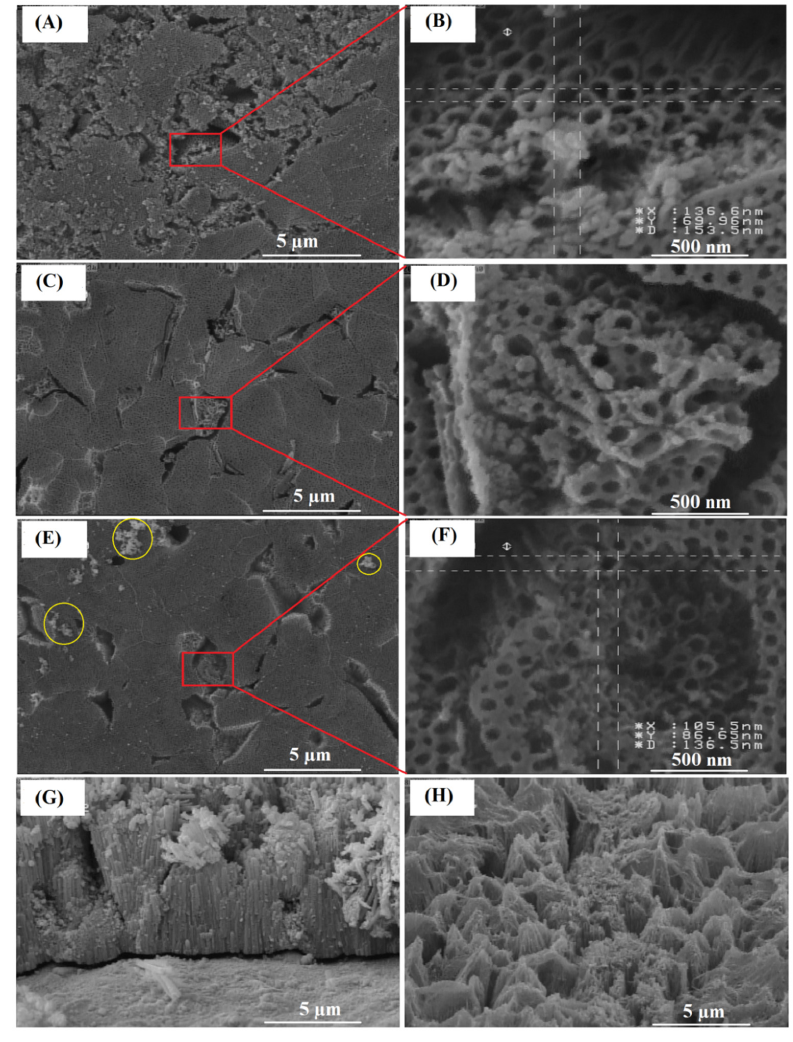
Figure 2. SEM images of decorated CT with Pd photo-deposition: Pd-CT-1 ( A , B ), Pd-CT-2 ( C , D ), Pd-CT-3 ( E , F ) at different magnitude, the red lines show the selected part of SEM images at higher magnitude, large agglomerates marked with yellow circles in ( C ), cross section ( G ), and side view ( H ) of Pd-CT-6.